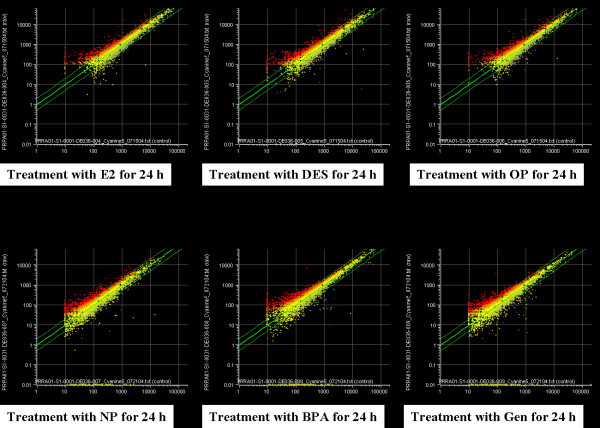
A scattergram of gene expression analyzed by DNA microarray. For each gene, the relative mRNA level in the control is given on the x axis and the expression level for the same transcript in the experimental sample (estrogenic compound exposed) is plotted on the y axis. Each graph displays two lines indicating 2-fold up-regulation or down-regulation in the expression level of each individual probe set comparing treated vs. control sample. The linear line (P < 0.05) was fitted to the microarray data.